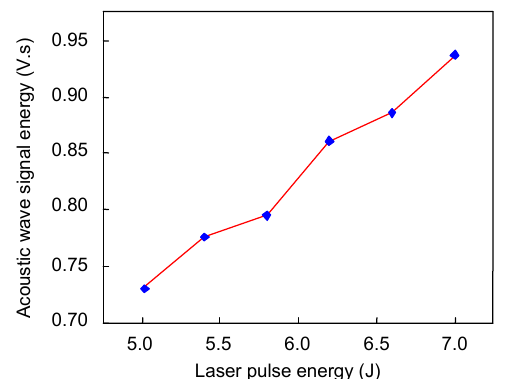
Fig. 4 | Effect of laser pulse energy on acoustic wave signal energy.